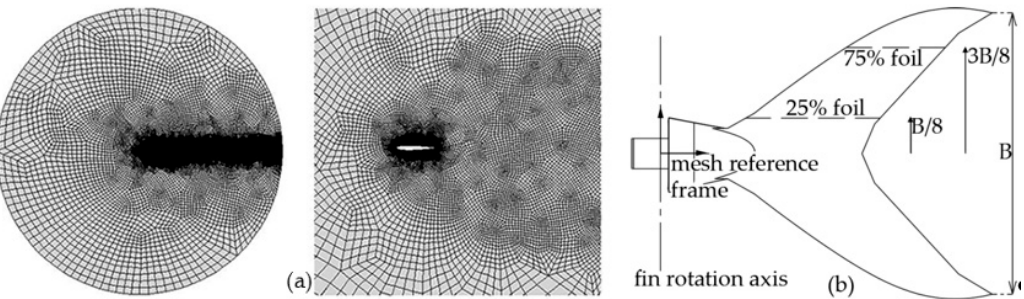
Figure 8. ( a ) Two-dimensional mesh used in computational fluid dynamics (CFD) analysis. ( b ) Fin geometry and foil definition.